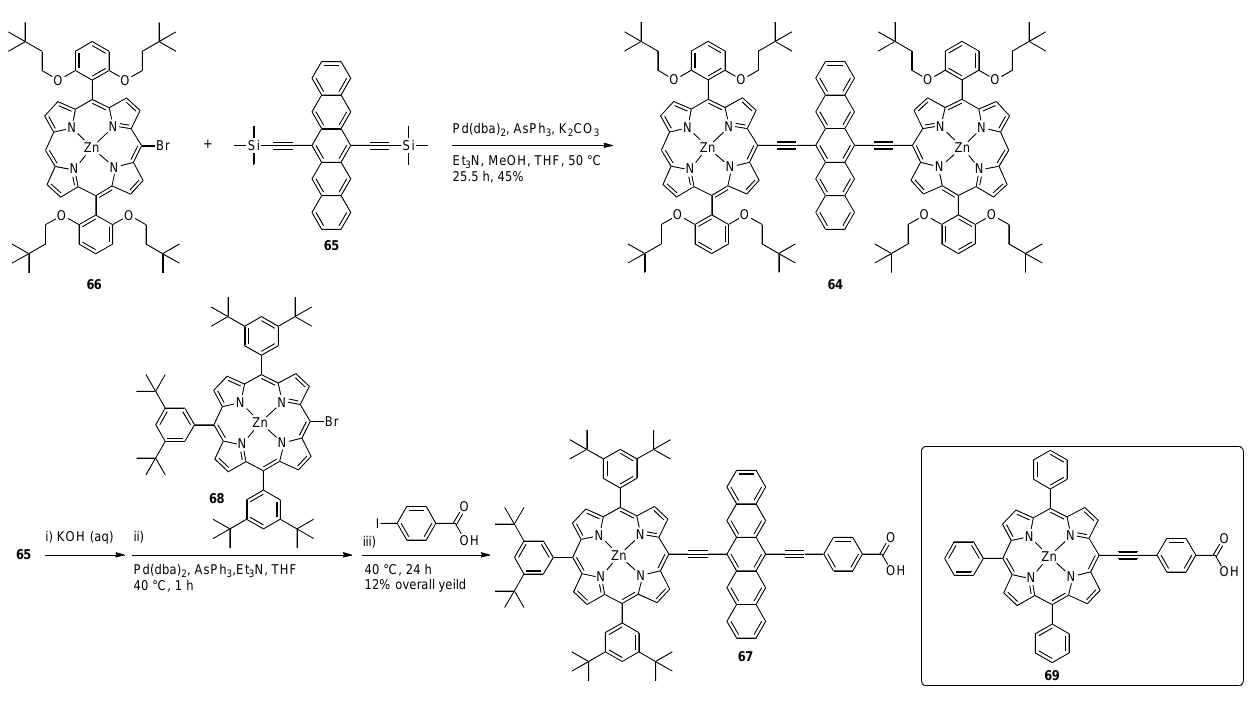
Scheme 6. Synthesis of porphyrin functionalized pentacenes 64 and 67 . Inset: Model compound 69